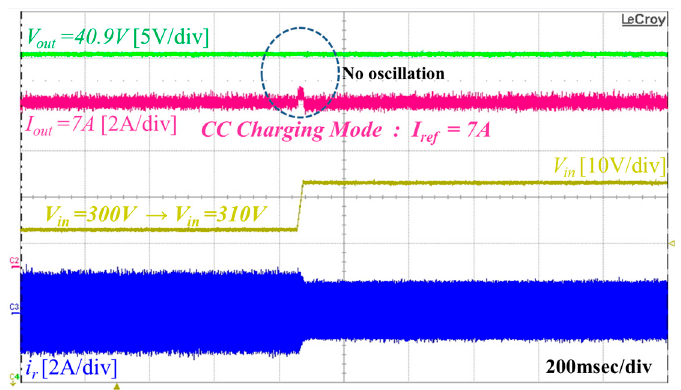
Figure 14. Experimental waveform of the proposed compensator with the CC mode under step-change of the input voltage.